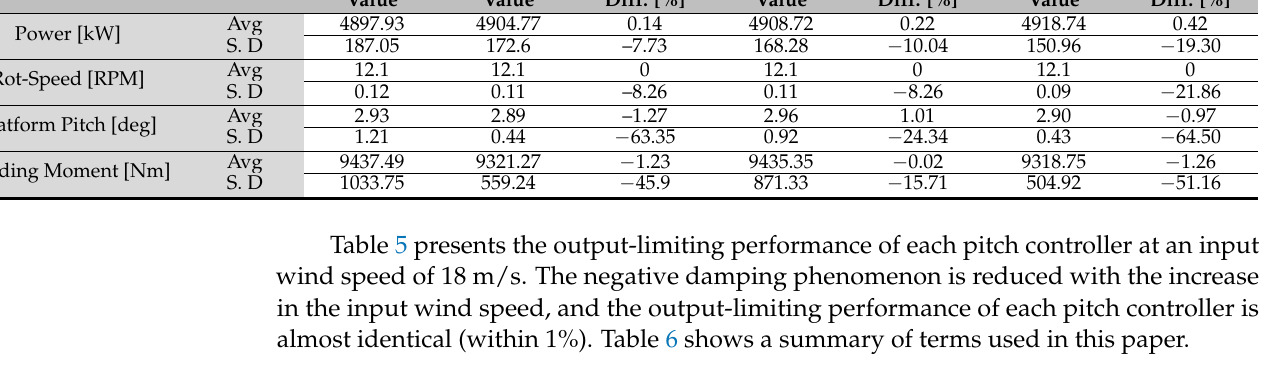
Table 4. Average value and standard deviation of output data based on pitch controller in 11.4 m/s.